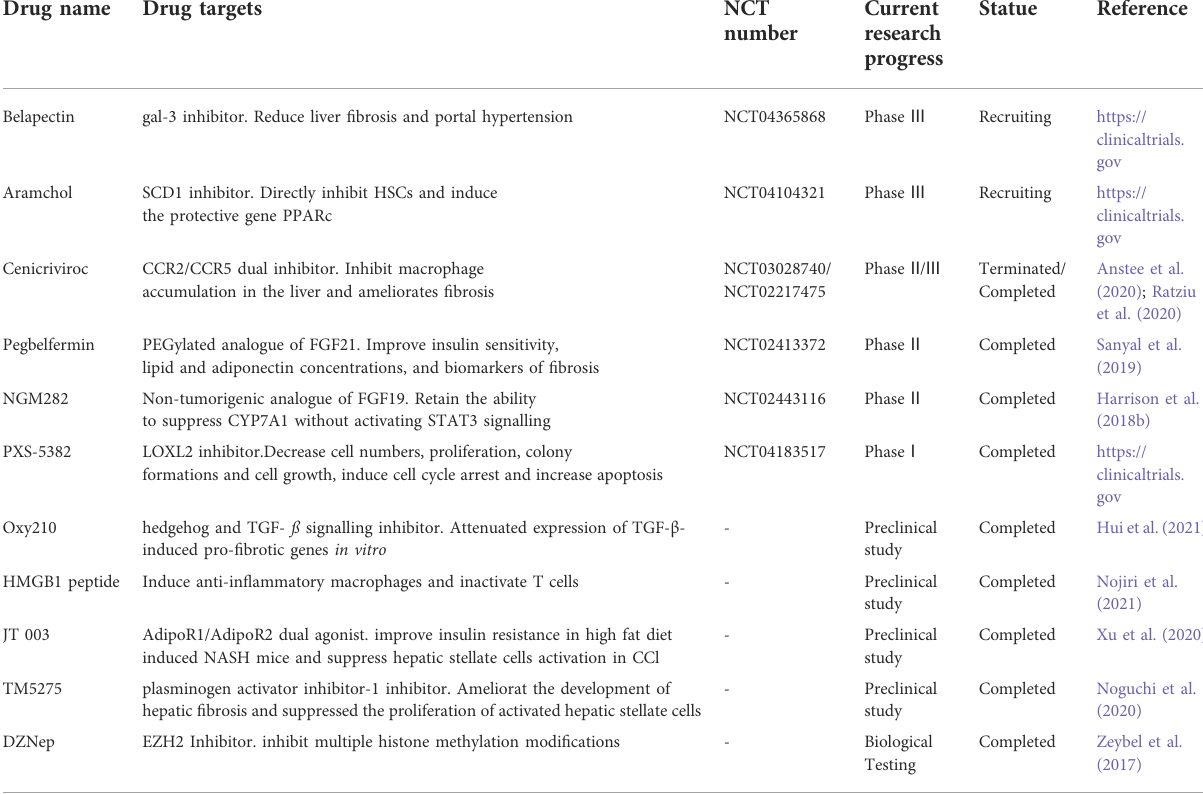
TABLE 4 Mechanism and Research Progress of drugs targeting extracellular matrix deposition anti fi brosis. Drug